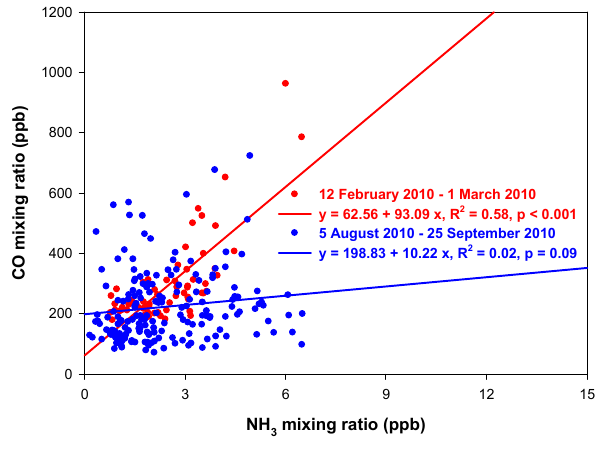
Fig. 6. Scatter plot of NH 3 versus CO for rush hours (06:00-10:00 CST) during the two sampling periods. As discussed in the text, outlier plumes are removed from this analysis in summer.